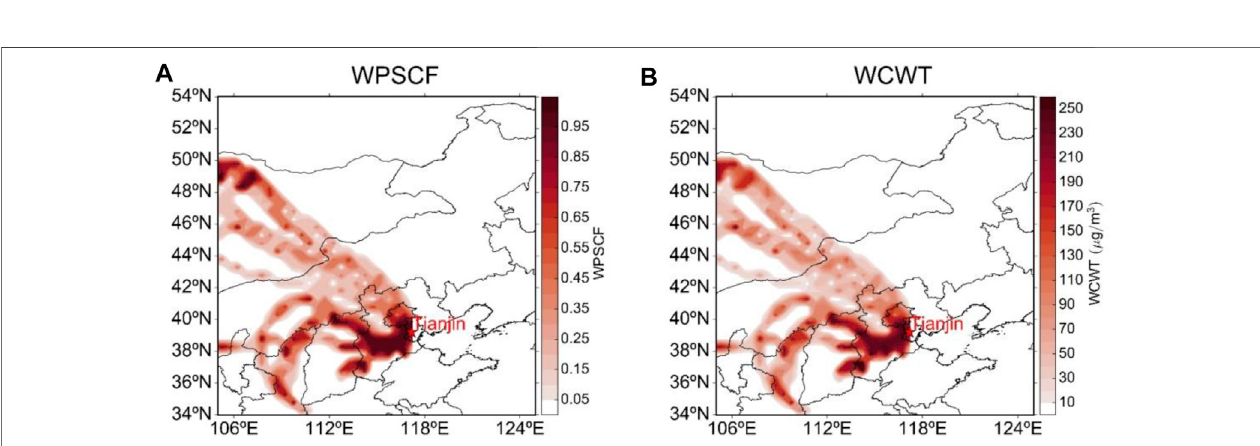
FIGURE 7 | PM 2.5 data obtained using the (A) WPSCF and (B) WCWT model for 10 to 15 January 2019 in Tianjin.